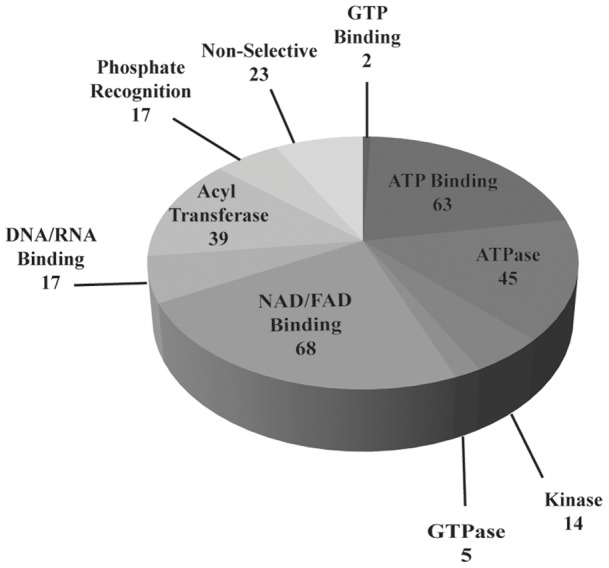
ATP-ABP labeling profile of skeletal muscle mitochondrial lysates from HFD and SD fed mice.293 total high confidence unique proteins were identified in total.